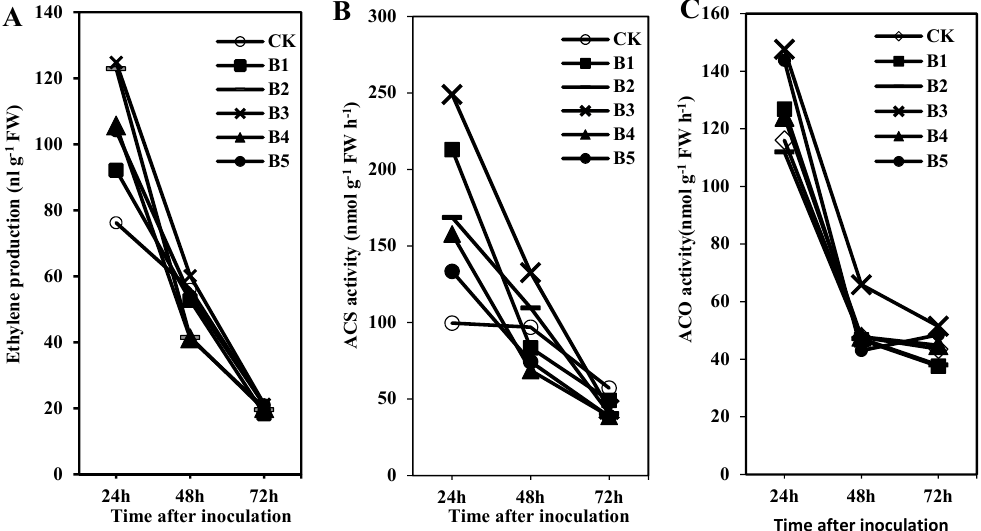
Figure 1. Changes in ethylene production and related enzyme activities of creeping bentgrass during an ISR response induced by BDO. ( A ) ethylene production; ( B ) ACS activity; ( C ) ACO activity. Creeping bentgrass seedlings were treated with different concentrations of BDO (CK = 0 µmol L − 1 ,